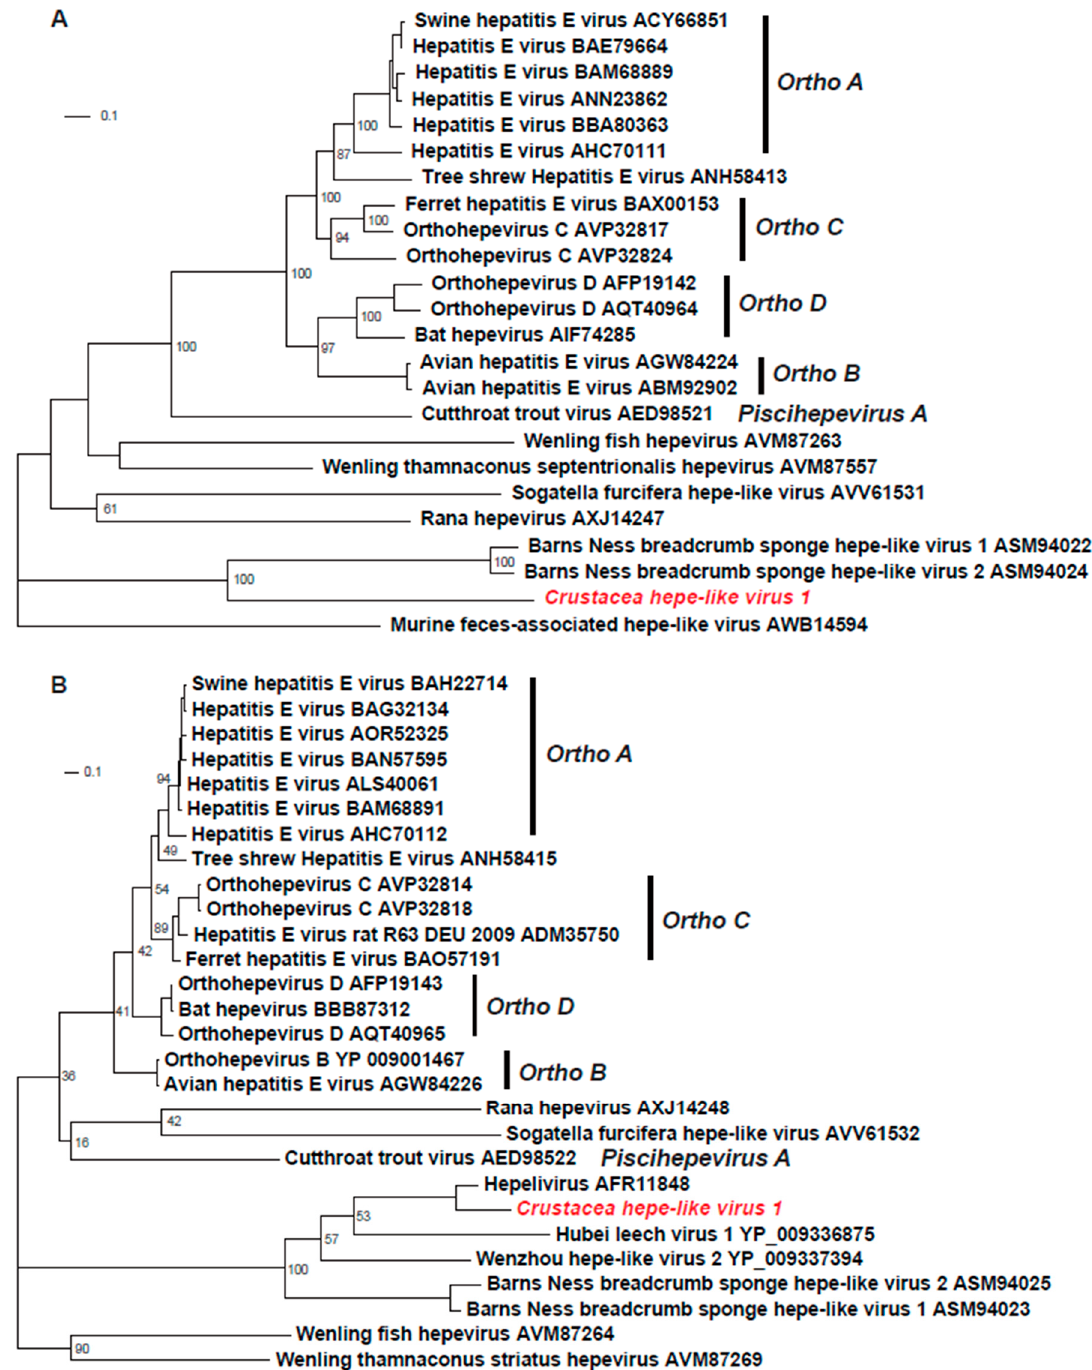
Figure 2. Phylogenetic analyses of the RNA-dependent RNA polymerase (RdRp) and capsid protein sequences of representative hepeviruses. ( A ) Phylogenetic analyses of RdRp sequences of representative hepeviruses. ( B ) Phylogenetic analyses of capsid protein sequences of representative hepeviruses. In both panels, Ortho represents Orthohepevirus and the novel virus is highlighted in red. The reference sequences were downloaded from GenBank and aligned using Mafft. Phylogenetic analysis was performed using RaxML, with the JTT amino acid substitution model and 1000 bootstrap replicates.